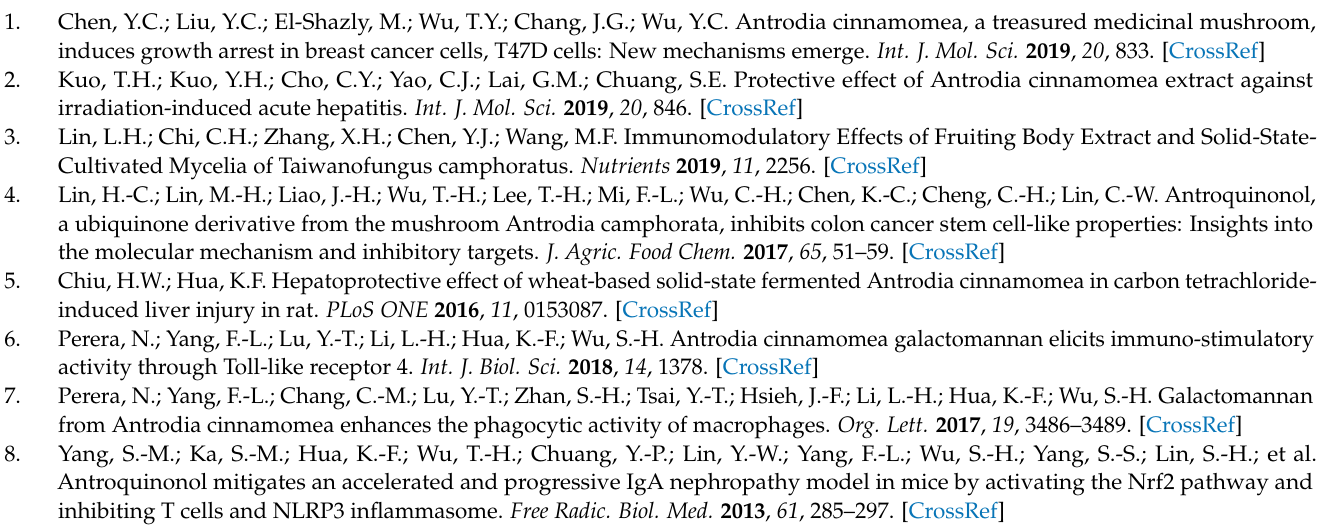
IC. Figure S1: DLS and zeta potential analysis of IC; Figure S2: Fluorescent microscopic analysis of C2C12 myoblasts treated with (a) AO, (b) IC and (c) AO-IC. Fluorescent spectrophotometric analysis of (d) IC, AO-IC and (e) AO; Section S2. IC improves C2C12 myoblasts migration. Figure S3: Comparison of C2C12 myoblasts migration after treatment with 25 µ g/mL of IC and AC at 0 h and 24. (a) cell migration percentage and (b) in vitro wound healing analysis. Section S3. Western blot Raw files. Figure S4. Western blot raw files of (a) N-cadherin, (b) N-cadherin- β -actin, (c) β -catenin, (d) β -catenin- β -actin, (e) p-PKC α / β II, (f) PKC α / β II- β -actin.